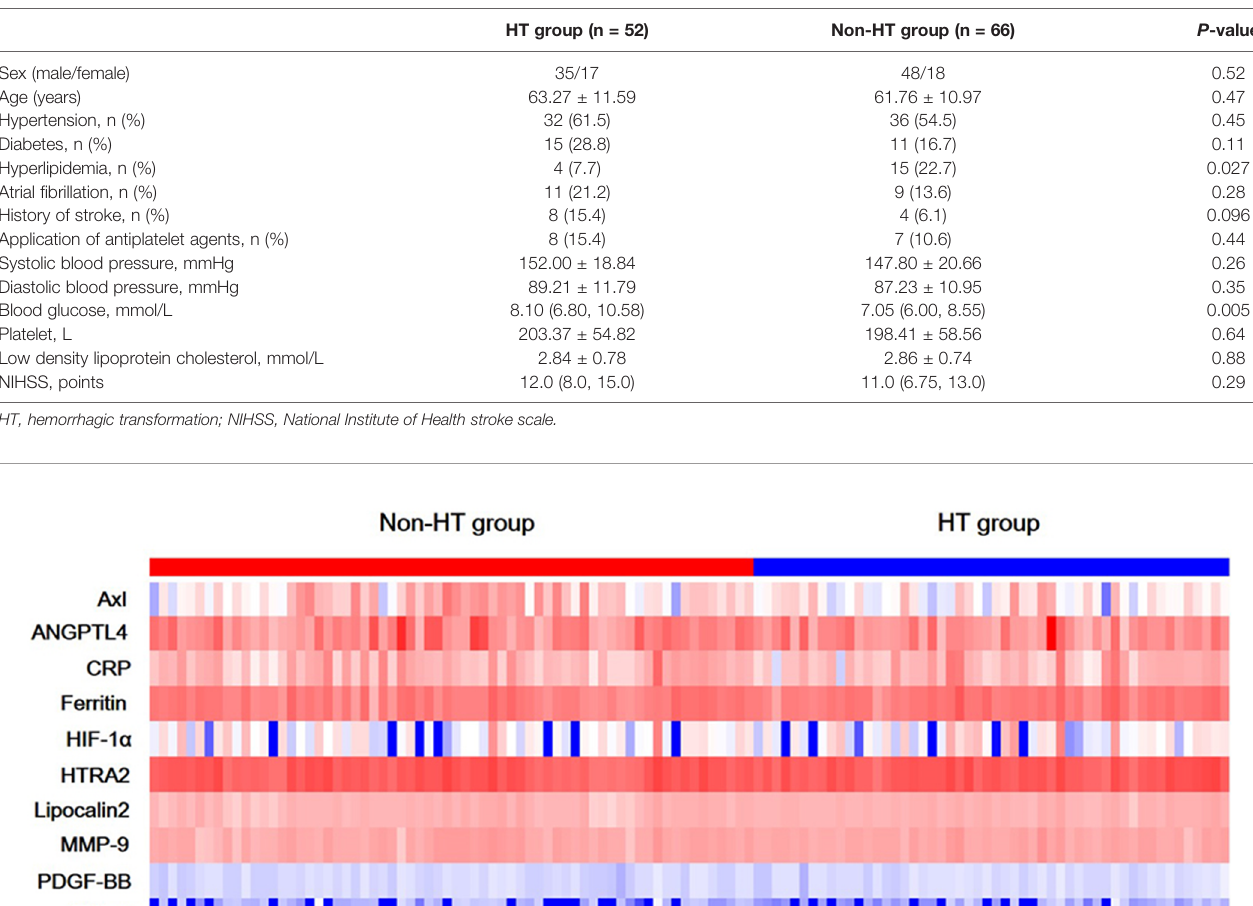
TABLE 1 | Demographical and clinical features of HT and non-HT groups.